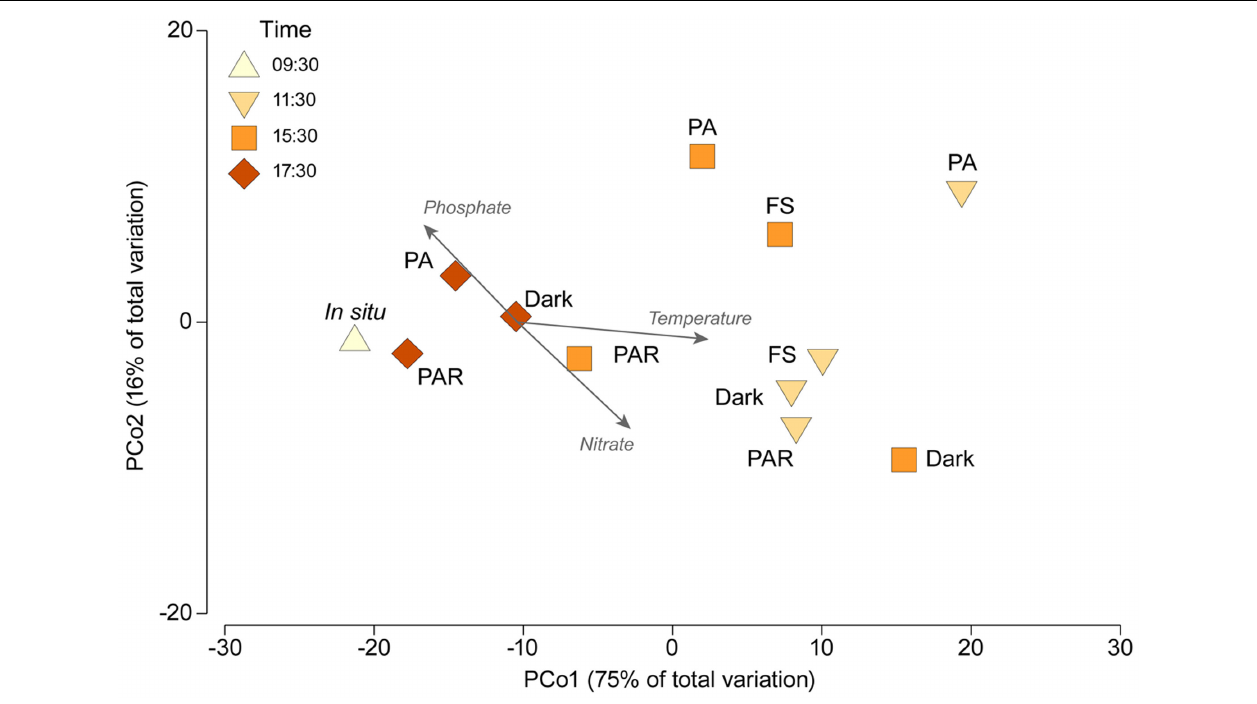
FIGURE 5 | Principal coordinates analysis (PCoA) ordination showing variation in active bacteria community structure associated with the different treatments and time periods. Vectors show those abiotic factors shown to be correlated ( r > 0.2) with PC Axis 1 or 2. Treatments acronyms: FS (full sun treatment between 280–700 nm), Dark (cover by aluminum foil and black plastic bags), PAR (400–700 nm, Photosynthetically Active Radiation), and PA (320–700 nm, UVR and